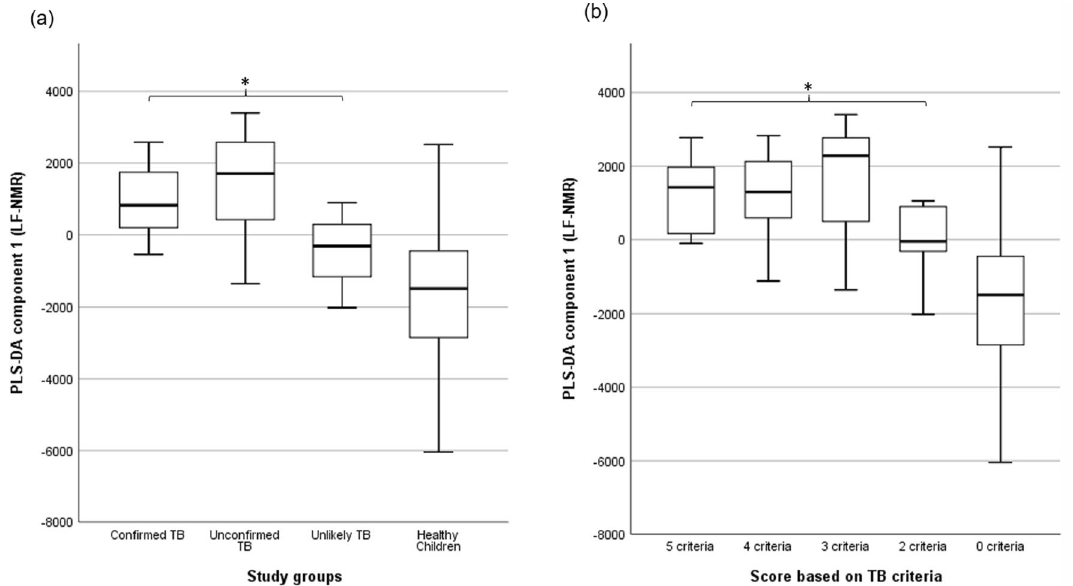
Figure 6. Association between partial least squares discriminant analysis (PLS-DA) scores and ( a ) study groups, and ( b ) the number of clinical criteria compatible with TB in 109 urine spectra acquired by low-field proton (1H) nuclear magnetic resonance. The central horizontal line within the boxes represents the median. The boxes comprise the first and third quartiles, the tiles indicate the maximum and minimum values, and the asterisk indicates statistically significant differences (p-value < 0.05) between groups. TB: tuberculosis; PLS-DA 2, the second components of the PLS-DA model . IBM SPSS Statistics 26 (https:// www. ibm.